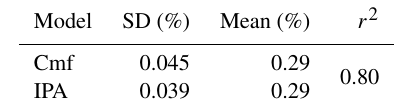
Table 2. Statistical parameters from model comparison between cmf and IPA for homogenous soil.